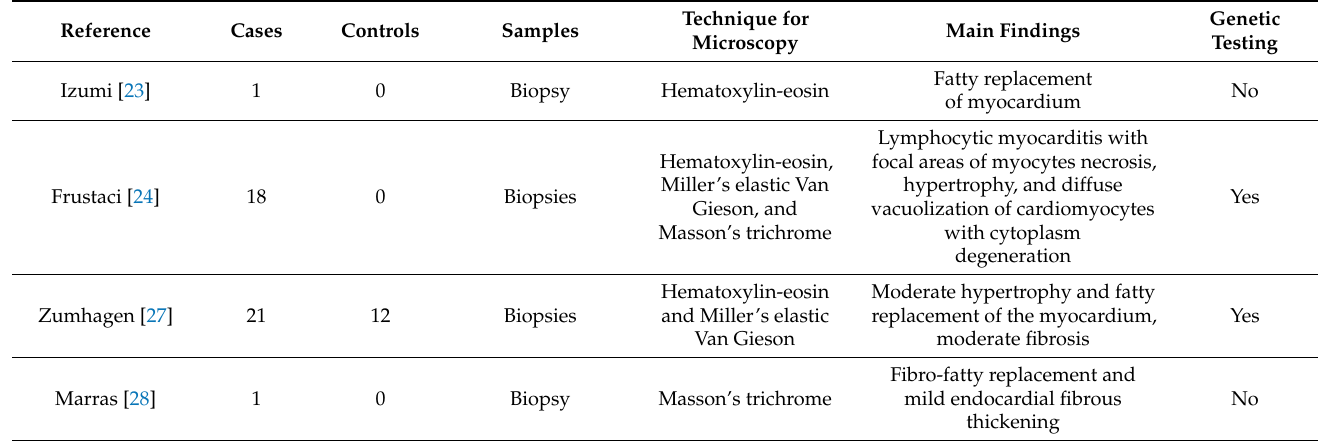
Table 2. Summary of the literature review regarding